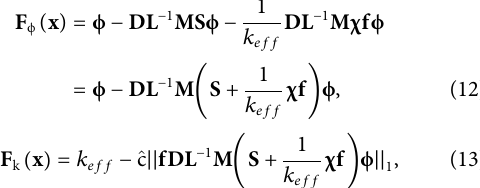
FIGURE 2 Radial geometry of the KAIST-3A benchmark